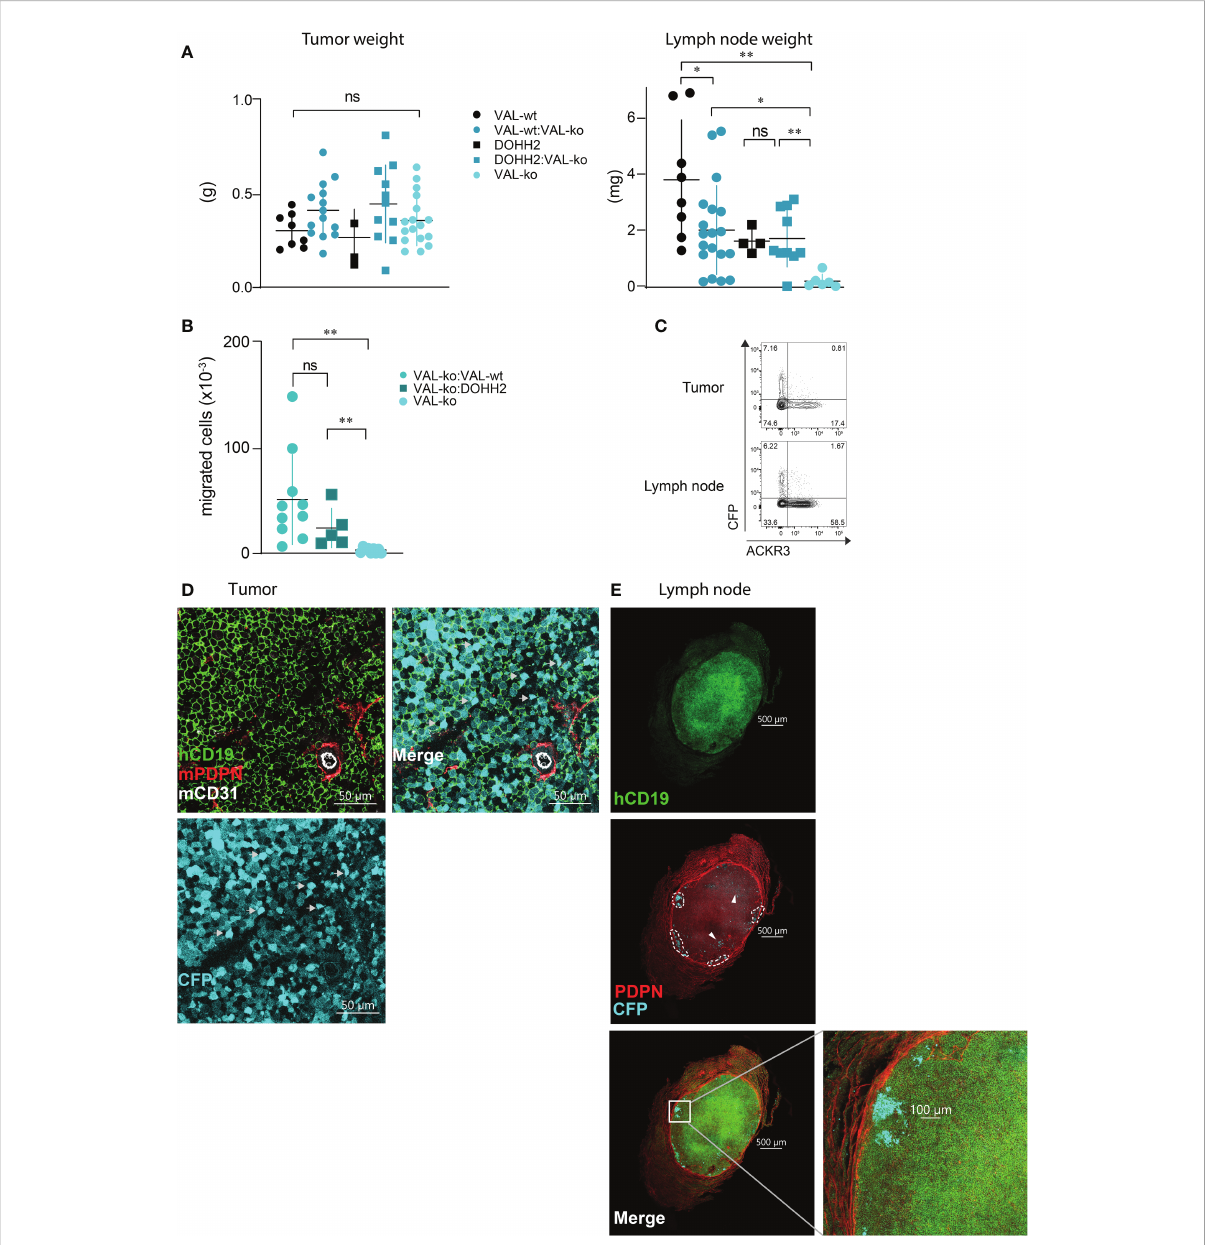
FIGURE 3 Migration of VAL-ko from the primary tumor to the draining lymph node is enhanced in the presence of ACKR3 expressing cells. (A) Tumor (left) and lymph node (right) weights from NOD/SCID common g -chain ko mice injected with 10 7 VAL-wt, VAL-ko and DOHH2 cells alone and as 1:1 mixture VAL-wt:VAL-ko and DOHH2:VAL-ko. Weights are reported as means ± SD from three independent xenograft experiments with 4-5 animals per group. Tumor and lymph node t-test single comparison: ns, p ≥ 0.05, *p ≤ 0.05, **p ≤ 0.01. (B) Total number of CFP + VAL-ko present in the draining axillary lymph node from the same experiments. Lymph node cells were analyzed by fl ow cytometry and gated for hCD19 + (HIB19 or SJ25C1), mCD45 - (30-F11) and CFP + expression (means ± SD, t-test single comparison, ns, p ≥ 0.05 **P ≤ 0.01). (C) Surface expression of ACKR3 on VAL-wt cells and CFP expression in VAL-ko extracted from a representative localized tumor (upper panel) and from the corresponding lymph node (lower panel). Representative data from one experiment shown in A (n= 4-5). (D) Confocal images of sections of a tumor generated by injecting a 1:1 mixture of VAL-wt and VAL-ko (CFP + ). Tumors were fi xed for 48h in a solution of 4% paraformaldehyde and Vibratome sections stained overnight with anti-hCD19 (mAb HIB19) anti-mPDPN (mAb 8.1.1) and anti-mCD31 (mAb MEC13.3). (E) Confocal images of sections of a draining lymph node from a tumor generated by injecting a 1:1 mixture of VAL-wt and VAL-ko (CFP + ). Lymph nodes were fi xed for 5h in a solution 4% paraformaldehyde and Vibratome sections were stained overnight with anti-hCD19 Ab (mAb HIB19), anti- mPDPN (mAb